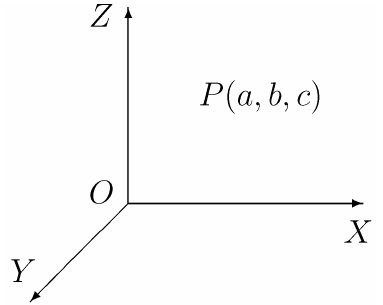
Figure 1. A three dimensional Cartesian coordinate